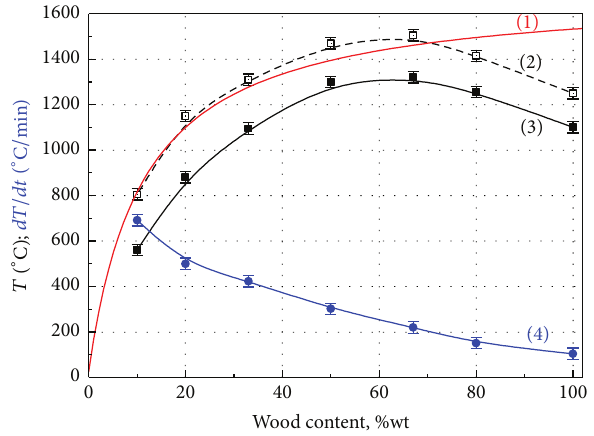
Figure 2: The adiabatic combustion temperature (1) and the temperature in the center (2) and on the wall (3) of the reactor and the heating rate of wood particles (4) versus the wood content.